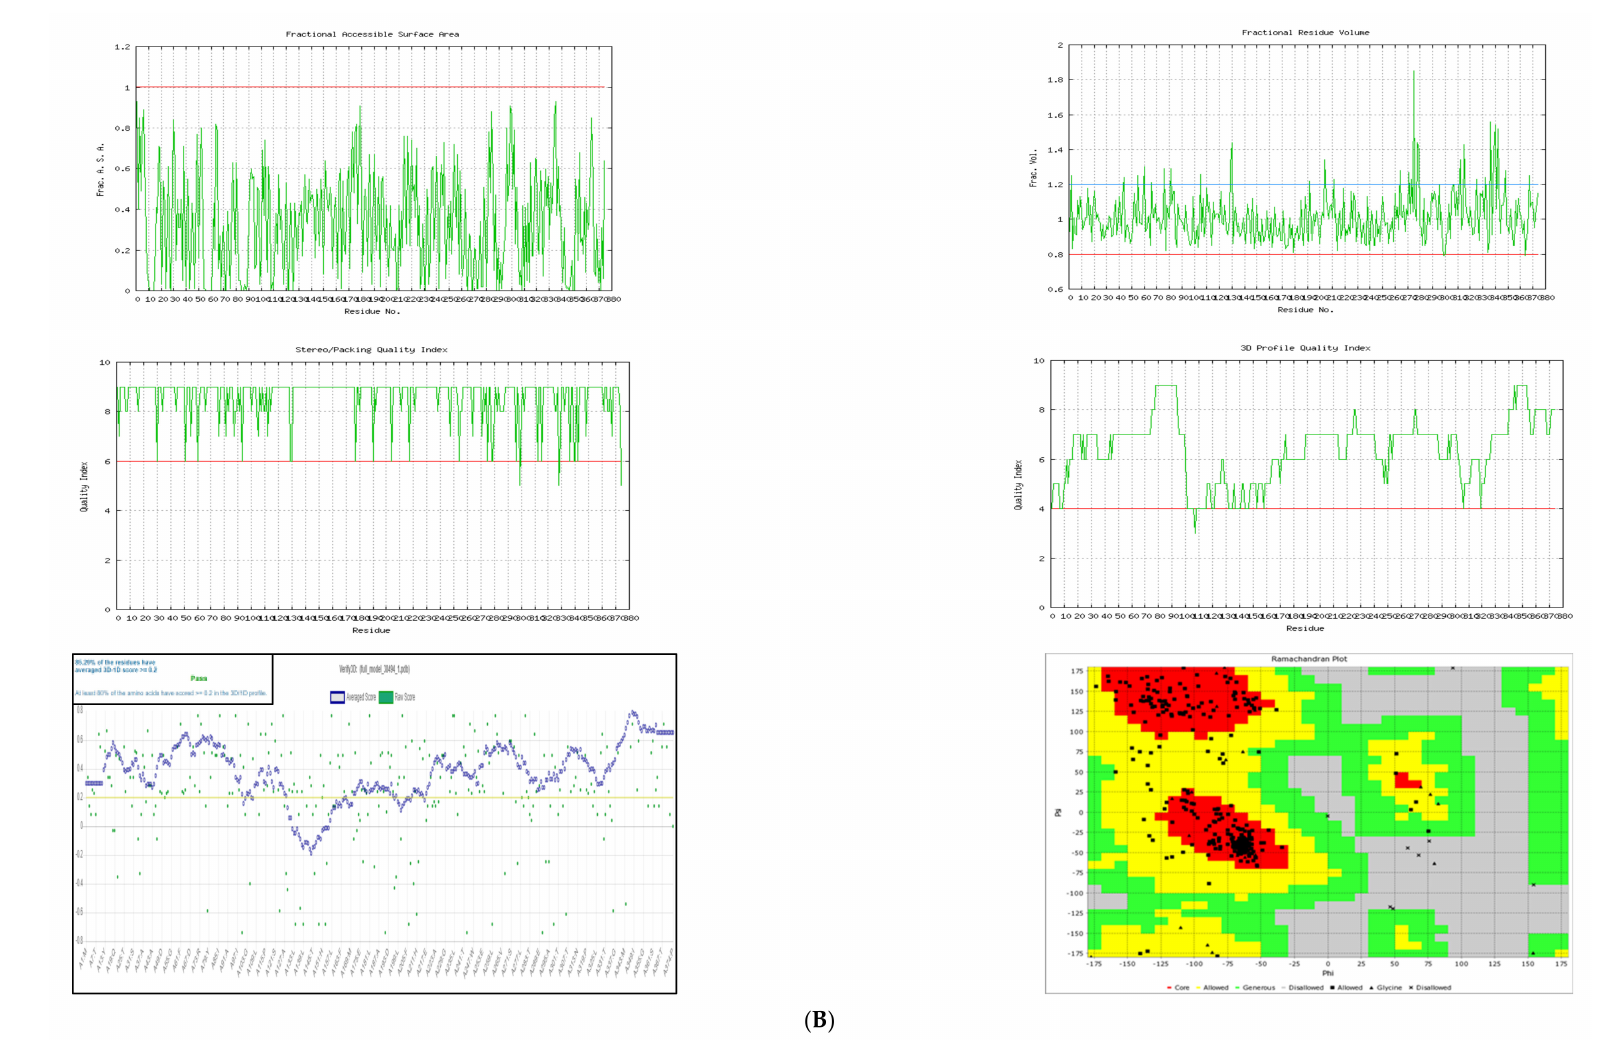
Figure 1. ( A ) Validation of modeled 3D structure of PhcA. ( B ) Validation of modeled 3D structure of